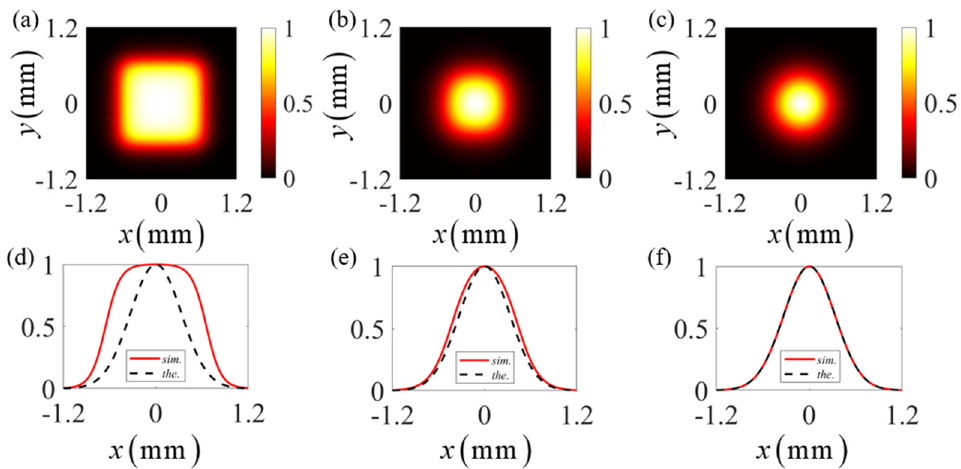
Figure 3. The spatial distributions for the spatial degree of coherence | γ ( r, − r ) | of a beam synthesized with ( a ) M × N = 5 × 5 pseudo modes, ( b ) M × N = 7 × 7 pseudo modes, and ( c ) M × N = 15 × 15 pseudo modes. The red curves in ( d – f ) show the corresponding cross line ( y = 0) of the simulation results, while the dotted black curves show the corresponding theoretical results.